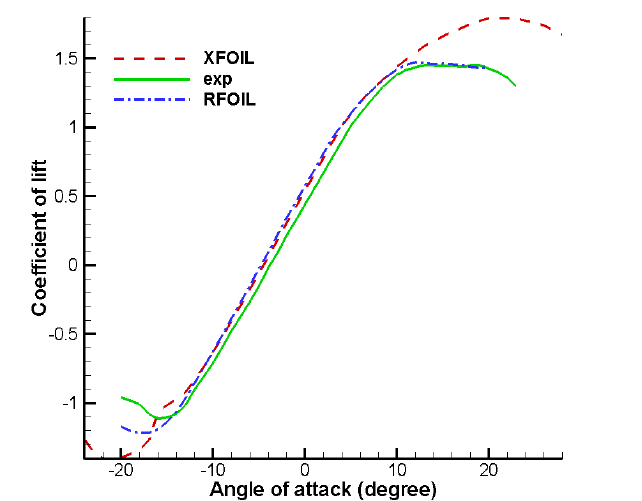
Figure 2. C vs . α for comparisons of XFOIL, RFOIL and experiment l